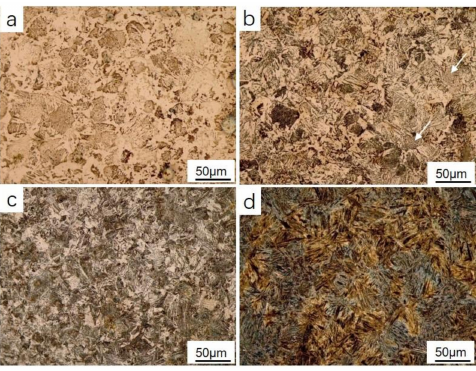
Figure 3. Continuous cooling transformation diagram of the experimental hot stamping steel.